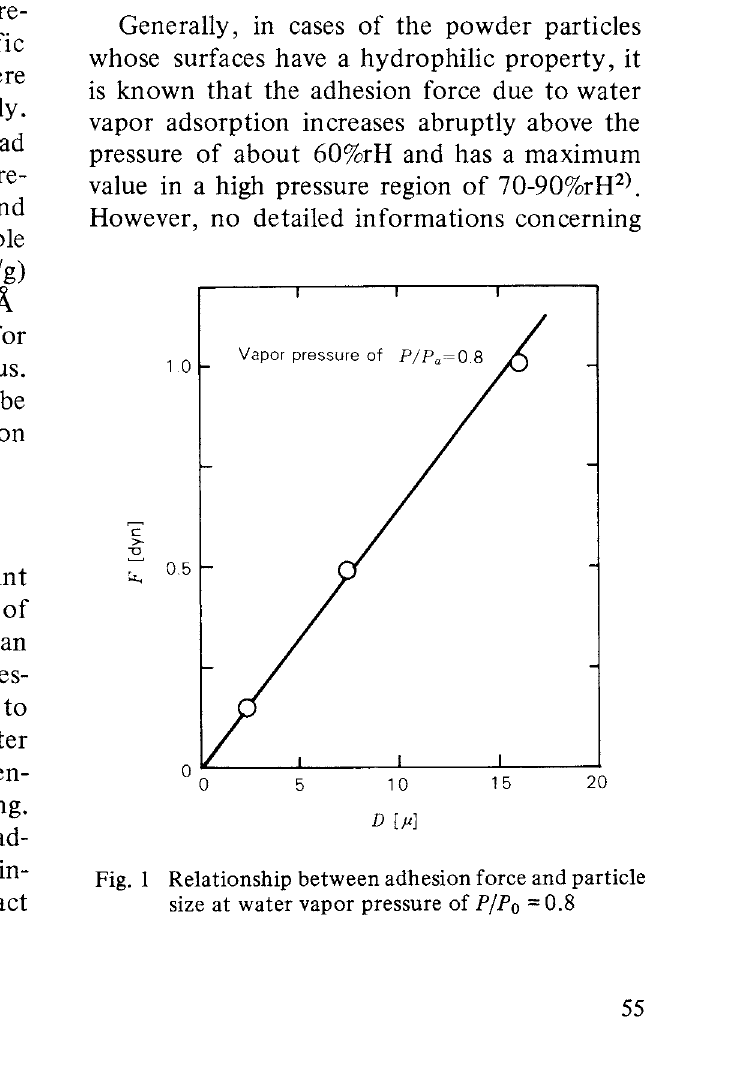
Fig. I Relationship between adhesion force and particle size at water vapor pressure of P/Po =